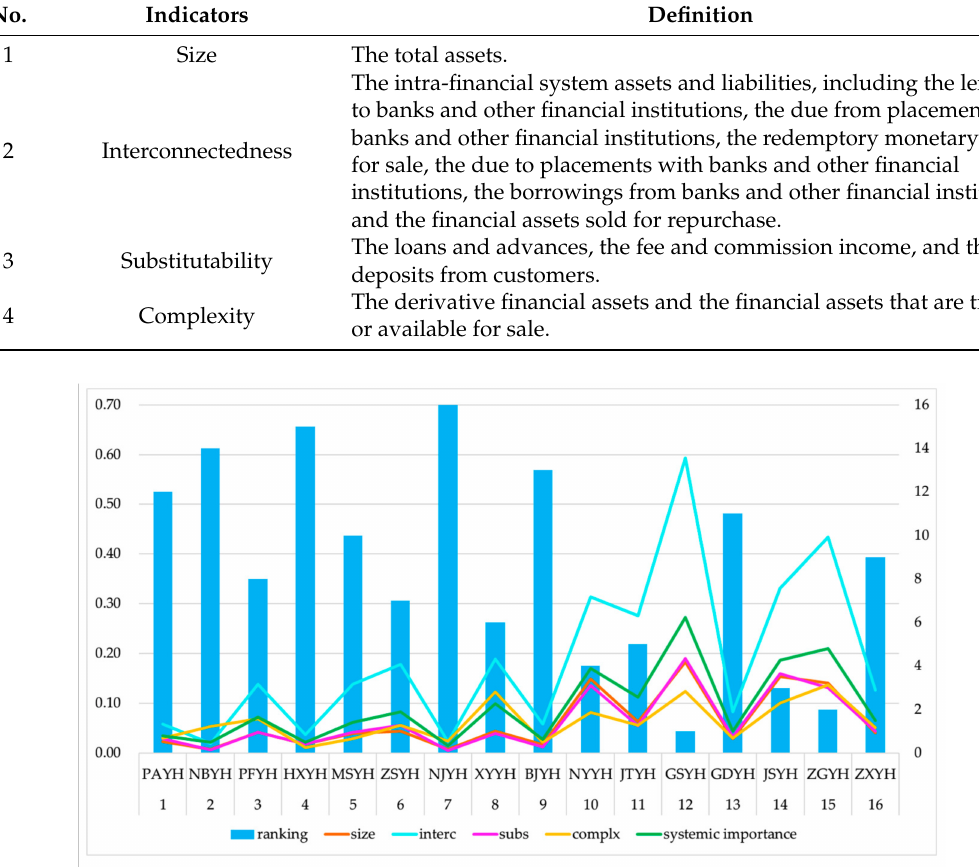
Figure 18. Measurements (The “size”, “interc”, “subs” and “complx” respectively refer to the values of the four indicators including size, interconnectedness, substitutability and complexity of a bank; the “systemic importance” refers to the measurement of the systemic importance of the banks based on the weighted average values of the four types of indicators; the “rankings” represents the ranking of a bank in terms of the systemic importance) and rankings (The left axis and right axis refers to the systemic risk evaluation and ranking of each bank, based on the indicator approach during the entire sample period) of systemic risk (the indicator